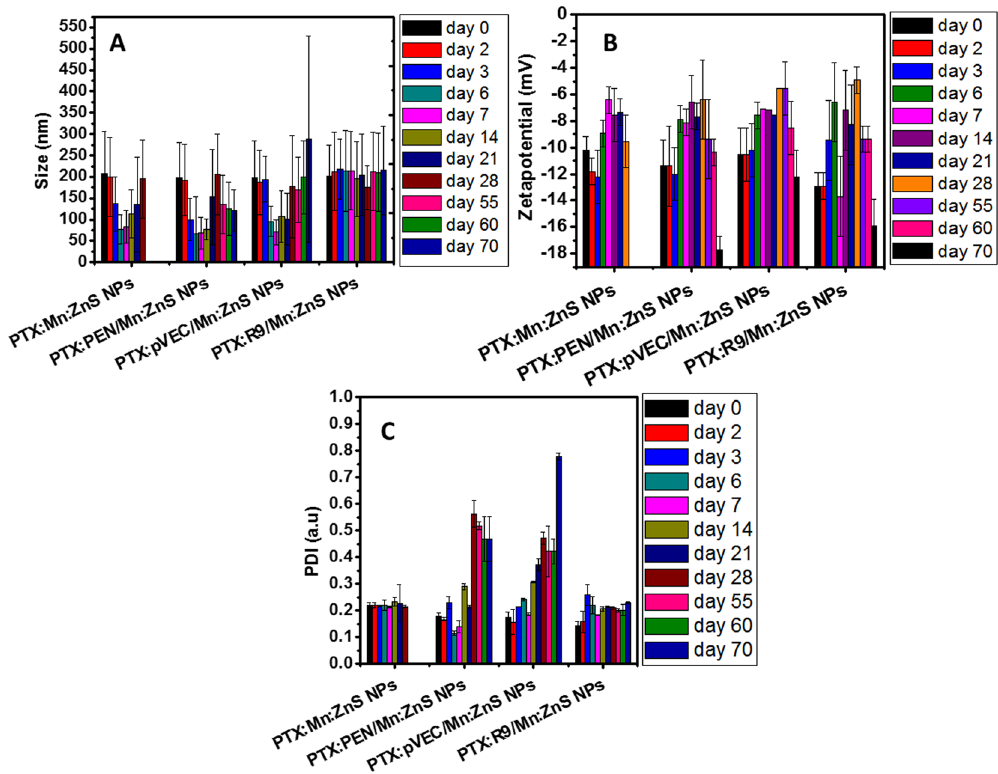
Figure 5. Long-term stability assessment of various PTX:CPP:NPs in 10% FBS at 37 °C for 70 days: ( A ) DLS analysis; ( B ) Zeta potential and ( C ) PDI values (n =